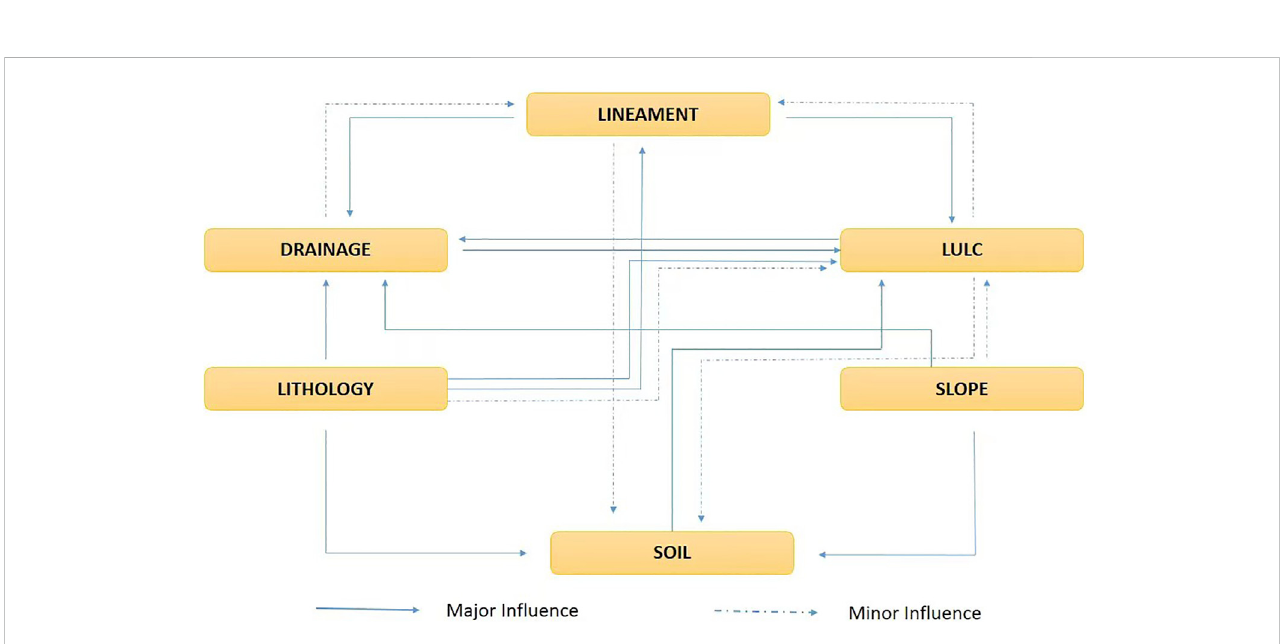
FIGURE 10 Schematic work fl ow showing integration of various parameters for GWPZ determination.